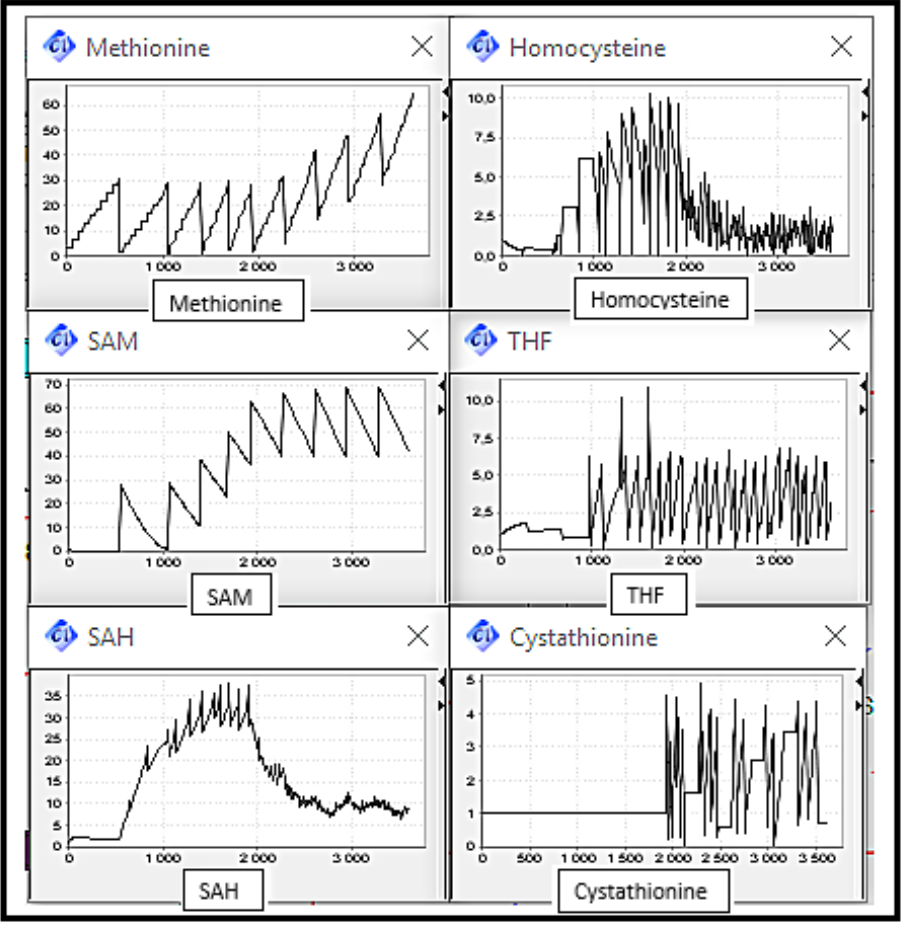
Figure 8. Simulation of the HFPN model representing the studied metabolic pathway in a normal case (Scenario